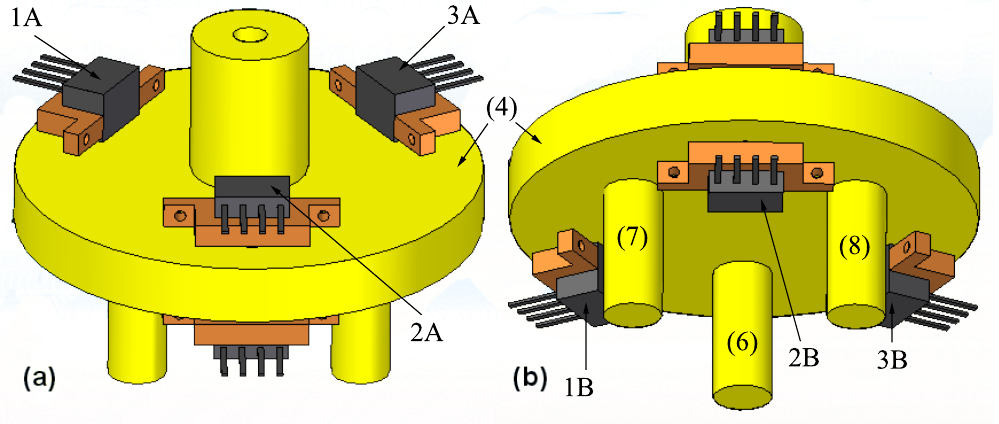
Figure 4. Body of force transmission (4) and arrangement of sensor units: ( a ) Top view; ( b ) Bottom